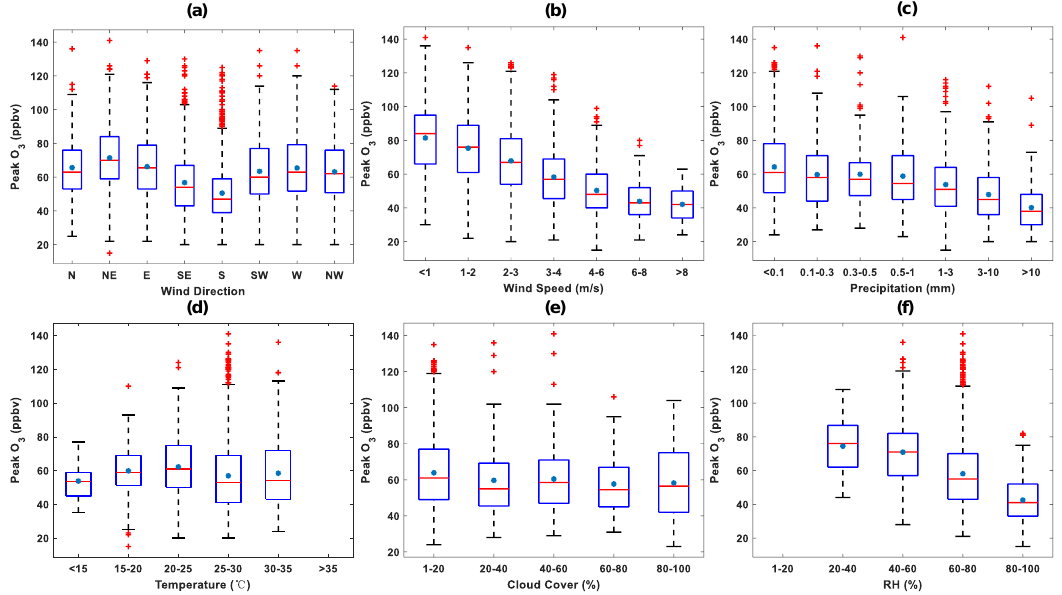
Figure 9. Box plots of peak O 3 vs. ( a ) wind direction; ( b ) wind speed; ( c ) precipitation; ( d ) temperature; ( e ) cloud cover; ( f ) RH (blue “*” represents the means; red lines are the medians; red “+” marks are the